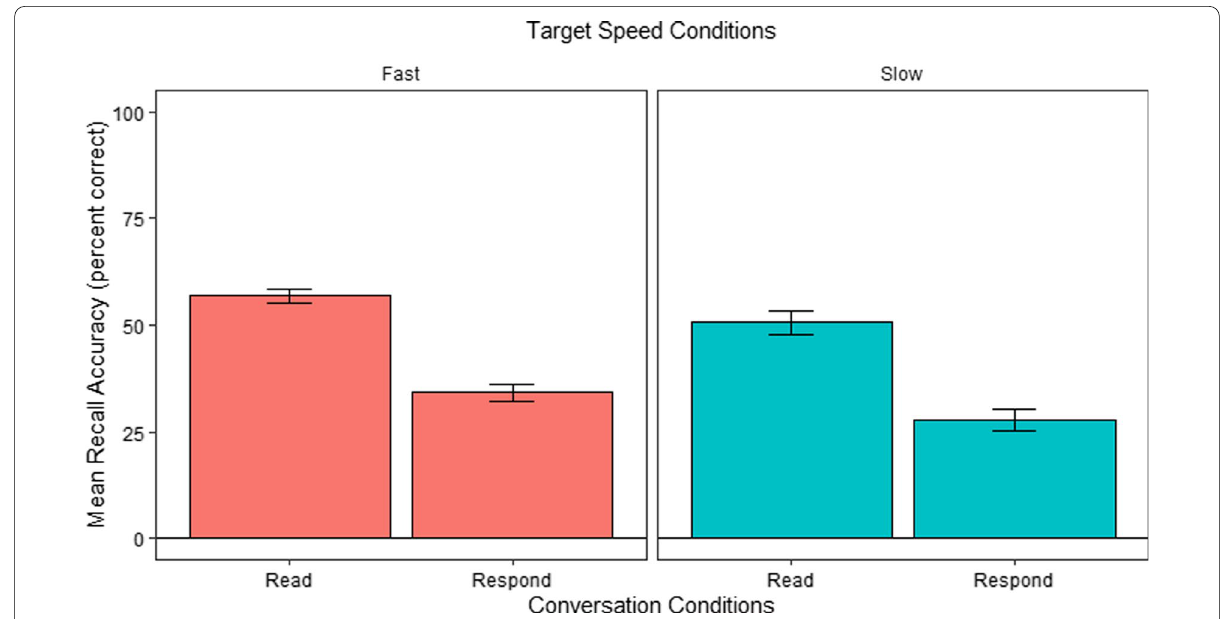
Fig. 10 Mean recall accuracy per Conversation and Speed conditions in E2. Error bars show the